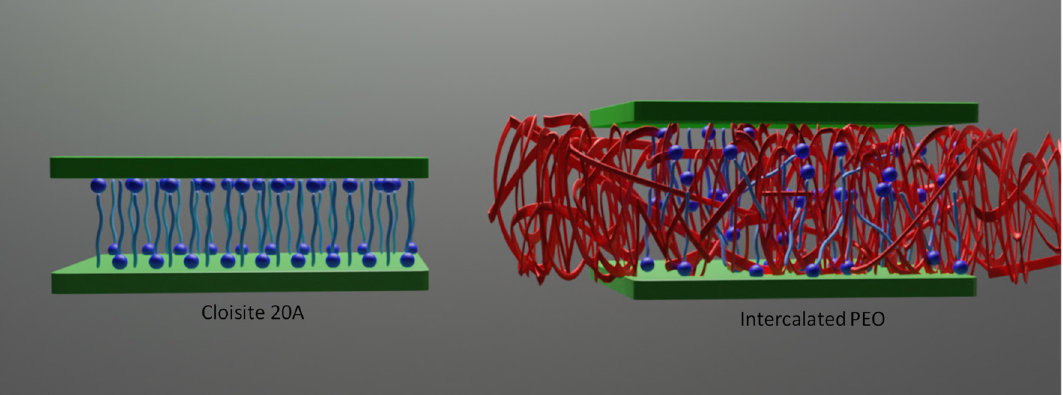
Figure 5. Illustrations of ( left ) Cloisite ® 20A containing organoammonium ion between the silicate layer and ( right ) hydrophilic channels formed after PEO intercalation. The silicate layer is green, organoammonium ion, blue, and PEO chains, red.